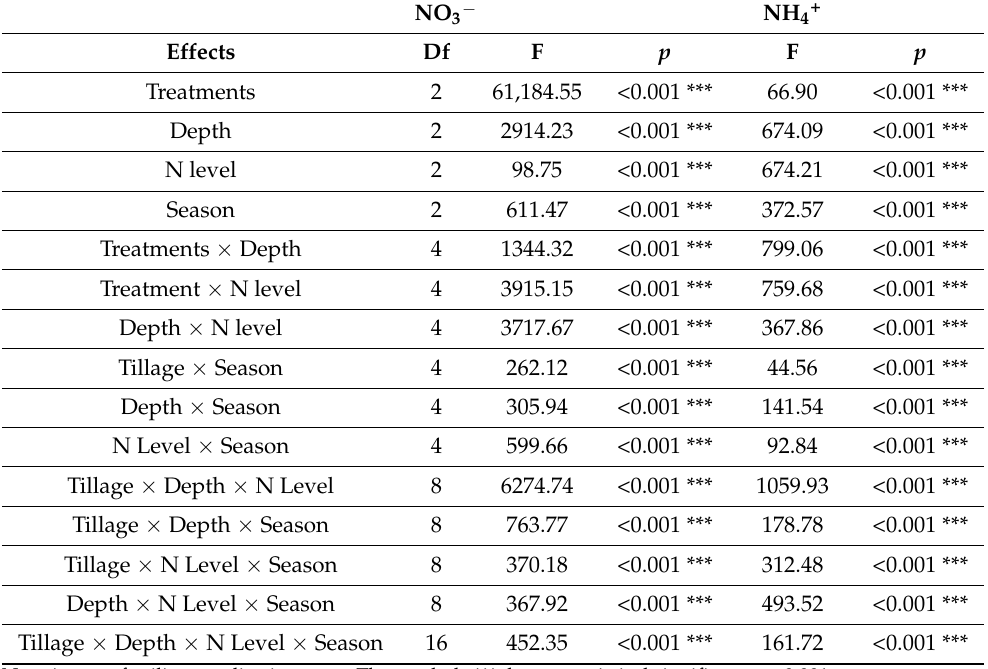
Table 1. ANOVA results of the effect of tillage treatments (NT, RT, and CT), depths (0–10, 10–20, and 20–30 cm), N-levels (0, 100, and 200 kg/ha), sampling times (April 2019, August 2019, and March 2020), and their interaction on soil-available nitrate (NO 3 − ) and ammonium (NH 4+ ).